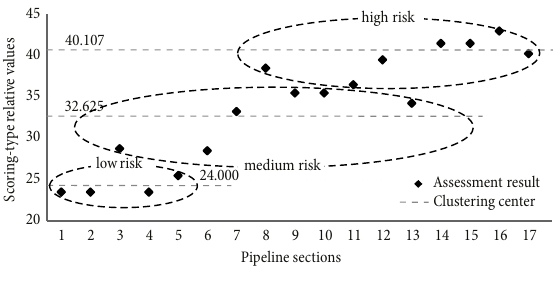
Fig. 12. The assessment results from numerical scoring method